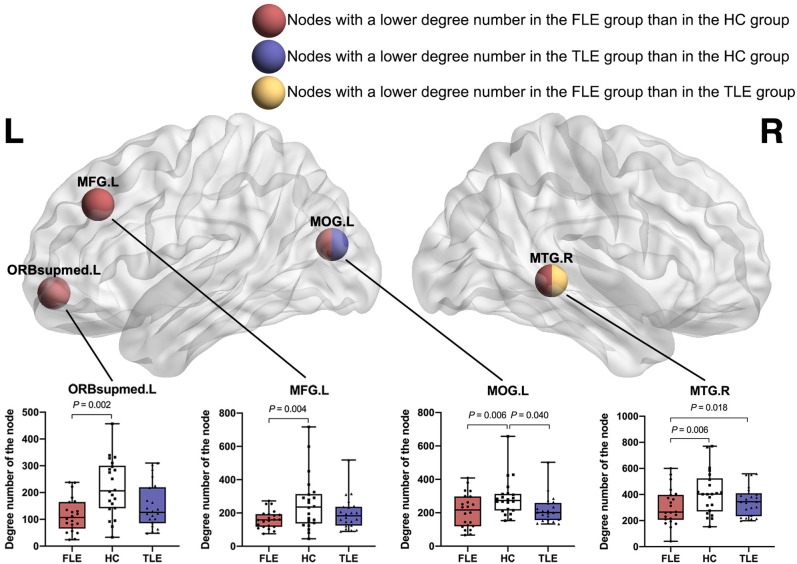
The nodes with a significantly lower degree number in the FLE group than in the HC group (red ball, adjusted P < 0.05), the nodes with a significantly lower degree number in the TLE group than in the HC group (blue ball, adjusted P < 0.05), and the nodes with a significantly lower degree number in the FLE group than in the TLE group (yellow ball, adjusted P < 0.05).